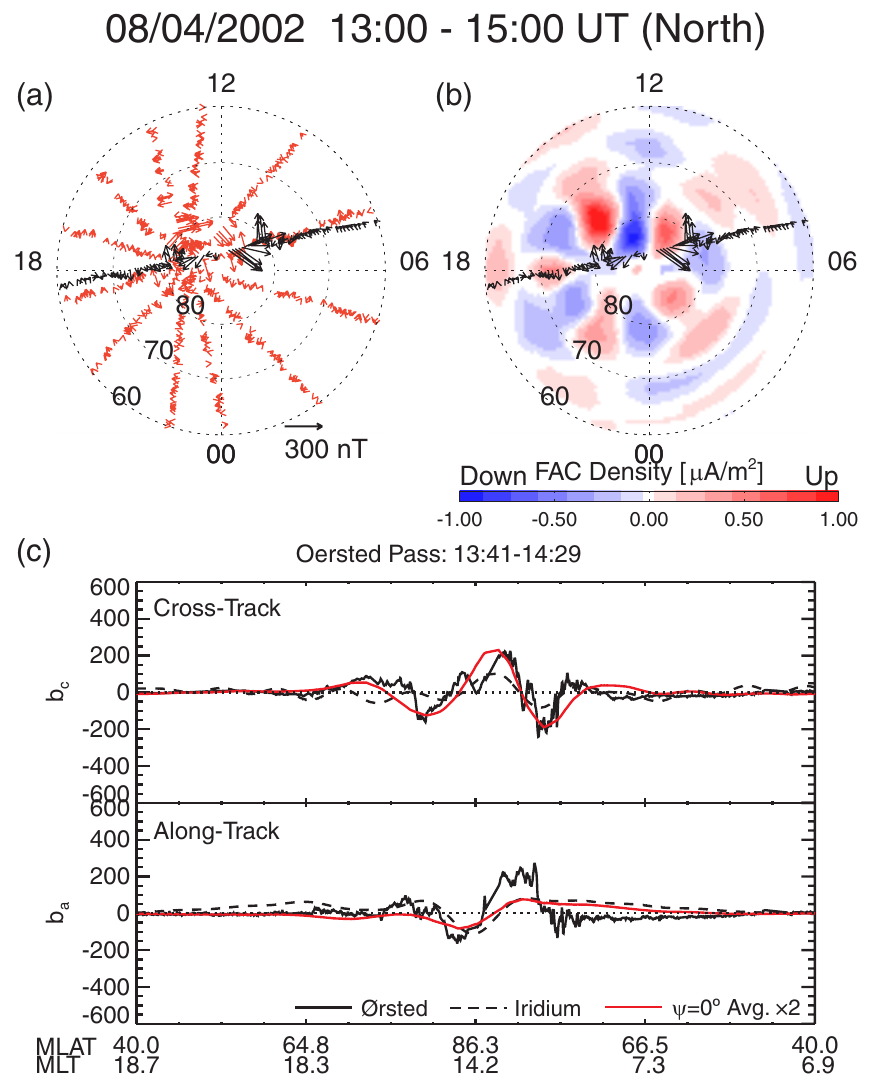
Fig. 7. Ørsted and Iridium observations for a northward IMF event from 4 August 2002 in the same format as Figure 6. Iridium data are from 13:00 to 15:00UT and Ørsted data are from the Northern Hemisphere pass from 13:41 to 14:29UT. Average solar wind and IMF conditions for this interval are given in Table 3. 34